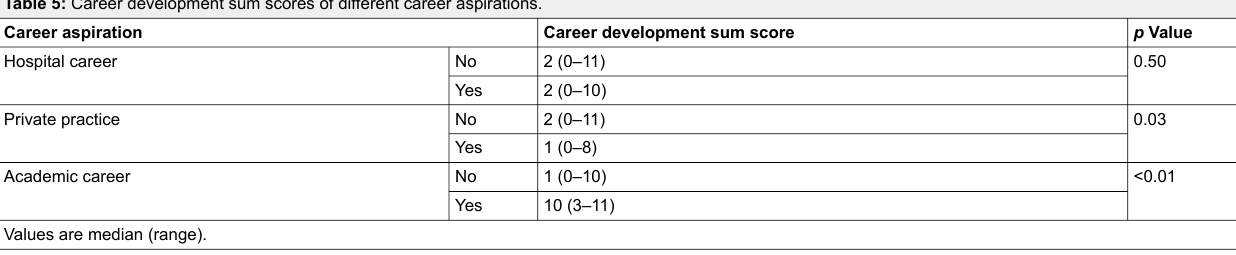
Table 6: Differences in the value of the objective career development depending on different variables.